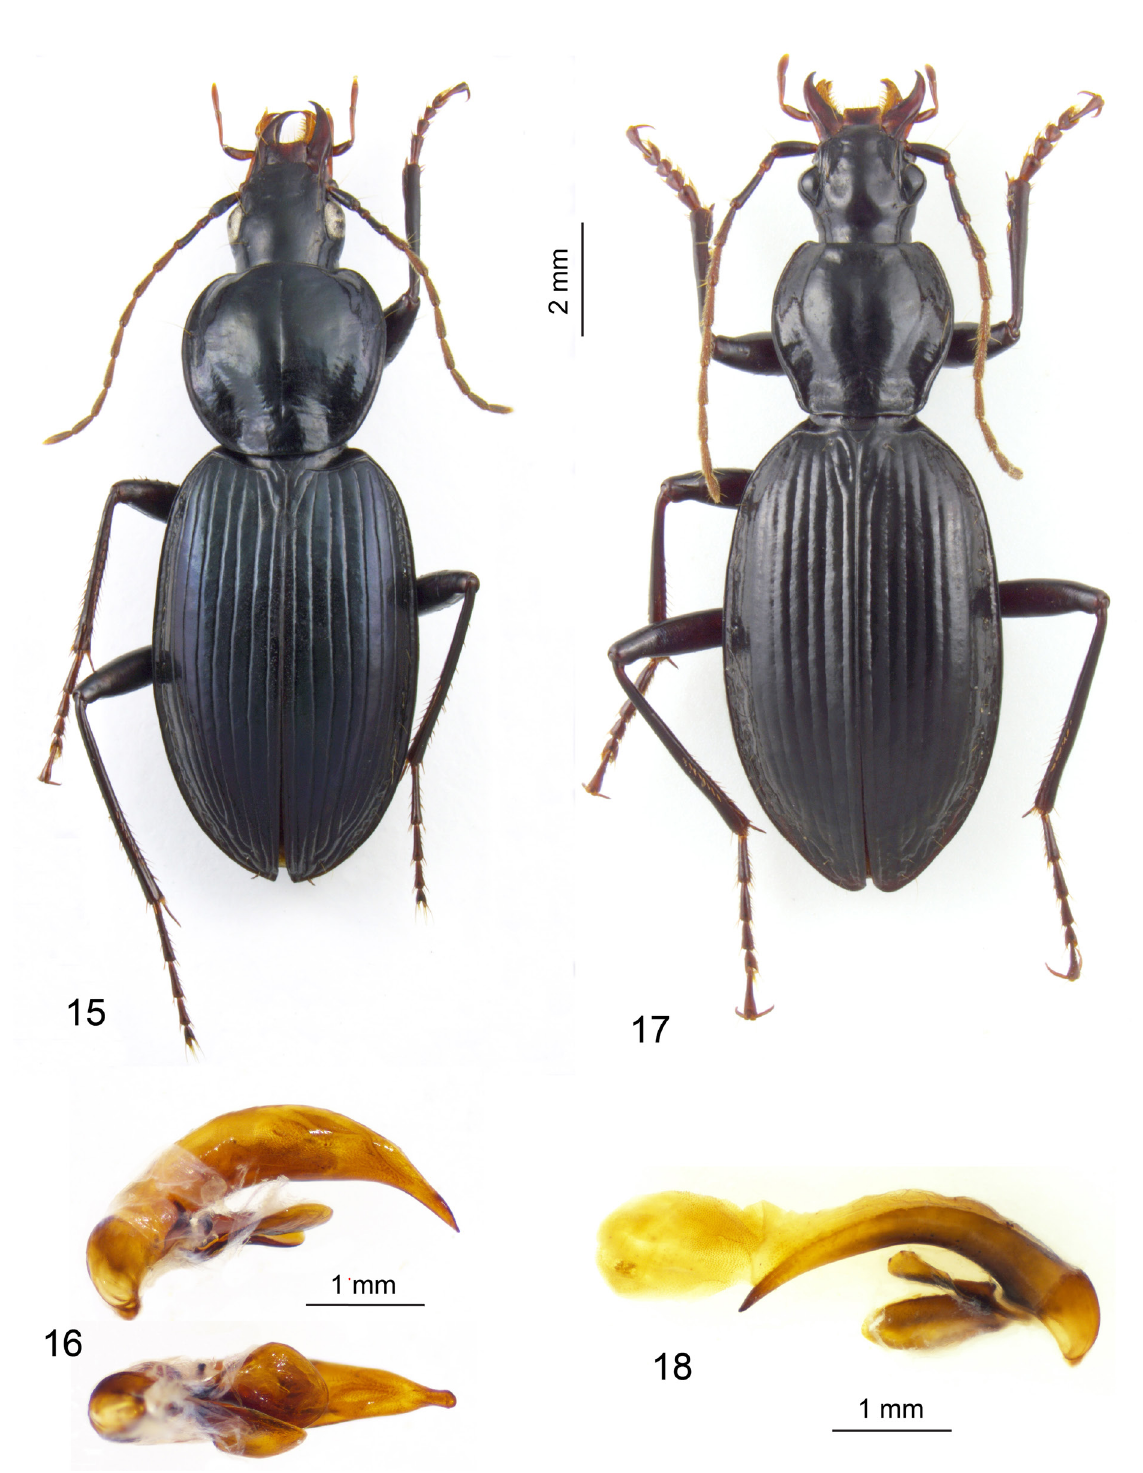
Figs 15–18. 15–16 . Dyscolus donosoi Moret sp. nov. 15 . Habitus of the female holotype (QCAZ, COI voucher PM402-02). 16 . Aedeagus, median lobe in lateral and ventral view. 17–18 . D. danglesi Moret sp. nov. 17 . Habitus of the male holotype (MNHN, COI voucher PM170-01). 18 . Aedeagus, median lobe in lateral